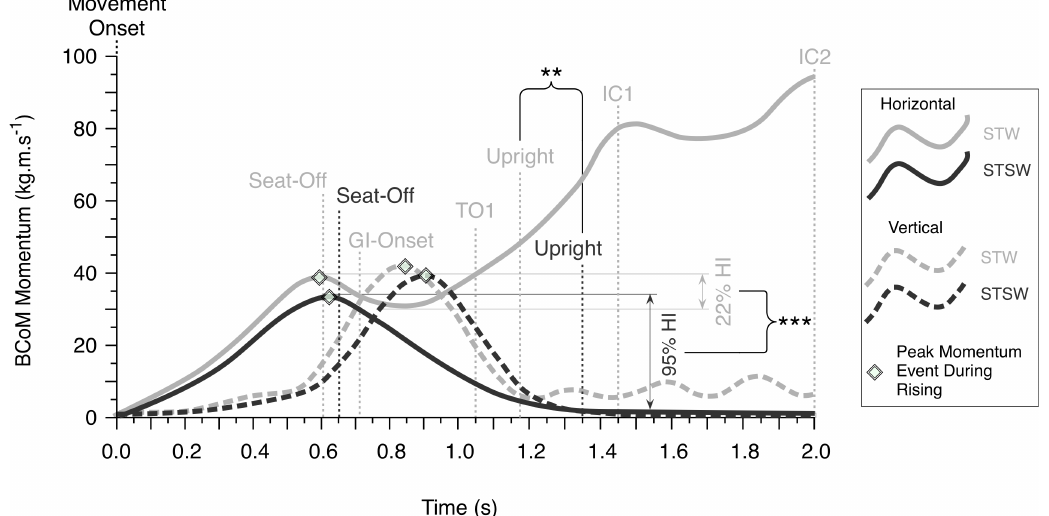
Fig 2. Mean STW and STSW horizontal and vertical mean BCoM momentum profiles. Group ensemble mean horizontal (solid lines) and vertical (dashed lines) momentum for STW (light shade) and STSW (dark shade). Vertical lines indicate mean time of movement events (Seat-Off, Gait-Initiation Onset (GI-Onset), 1st Toe-Off (TO1), Upright, 1st Initial-Contact (IC1) and 2nd Initial-Contact (IC2) with Movement-Onset representing the origin of x-axis). Peak momentum events, and mean Hesitation Indices (HI) during rising are indicated separately. Note that the time frame presented does not include GI-onset in STSW. (cid:3)(cid:3) Statistically significant between tasks at < 0.01; (cid:3)(cid:3)(cid:3) < 0.001.